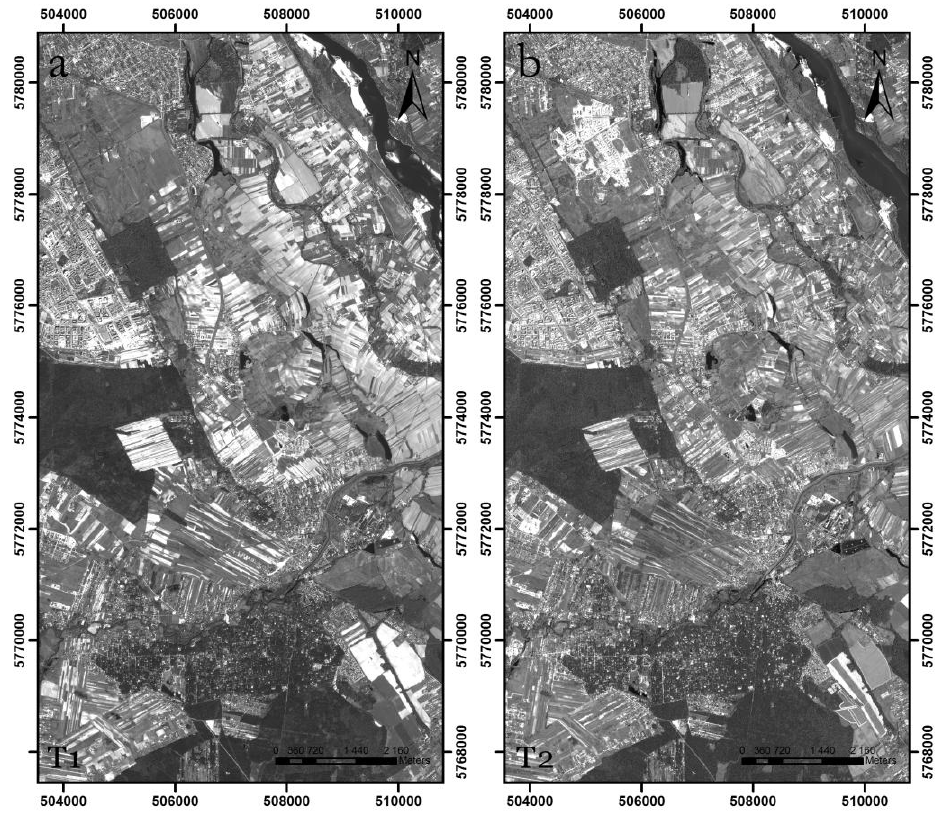
Figure 1. IKONOS panchromatic images of the suburbs of the Warsaw metropolitan area from the years: ( a ) 2002 (T1) and ( b ) 2008 (T2) used for algorithm testing.